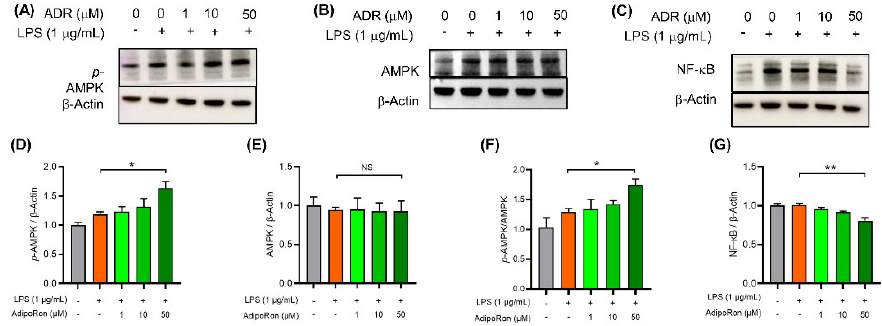
Figure 8. The expression of AMPK, p ‐ AMPK and NF ‐ B protein of BV2 cells. Expression of ( A ) phosphorylation status of AMP-activated protein kinase ( p -AMPK; molecular weight: 62 kDa), ( B ) AMPK-activated protein kinase (AMPK; molecular weight: 62 kDa), and ( C ) nuclear factor κ B (NF- κ B; molecular weight: 65 kDa) in BV2 cells was measured by immunoblot. BV2 cells were preincubated with AdipoRon (0–50 µ M) or vehicle (dimethyl sulfoxide) for 1 h before stimulation with lipopolysaccharide (1 µ g/mL) for 1 h. An amount of 10 µ g protein of each sample was used for gel electrophoresis. Column bars indicated quantified levels of target protein/Actin expression ratios ( D – G ), and the results are relative values whereby the expression level of the sham control was normalized to 1.0. n = 3 in each group. Results are presented as the mean ± SEM. LPS: lipopolysaccharide; ADR: adipoRon. * p < 0.05 and ** p < 0.01 . NS: p >